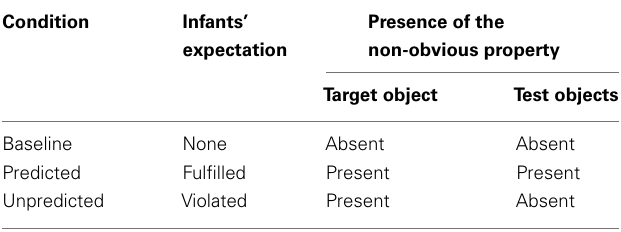
a target object, a high-similarity test object, and a low-similarity test object were created. The high-similarity object was the same shape and texture as the target object, but differed in size and color. The low-similarity object was a different shape, size, and color than the target object, but shared the target object’s texture.